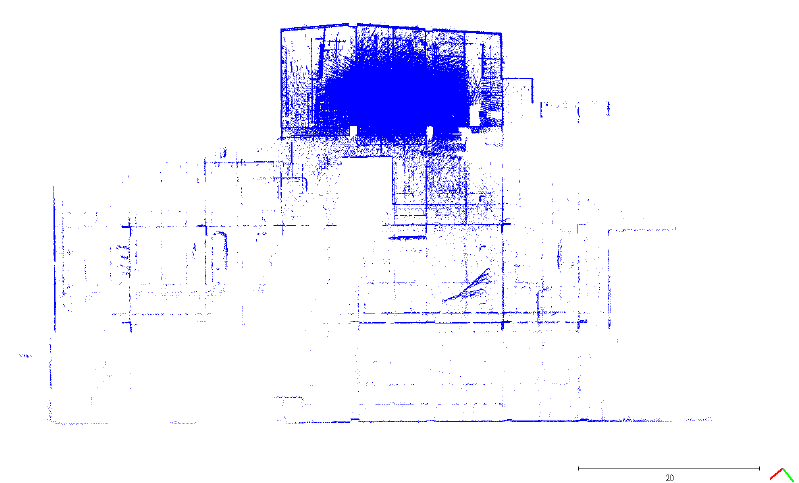
Figure 12. Handheld LiDAR point cloud after point cloud filtering for dataset DATA1.